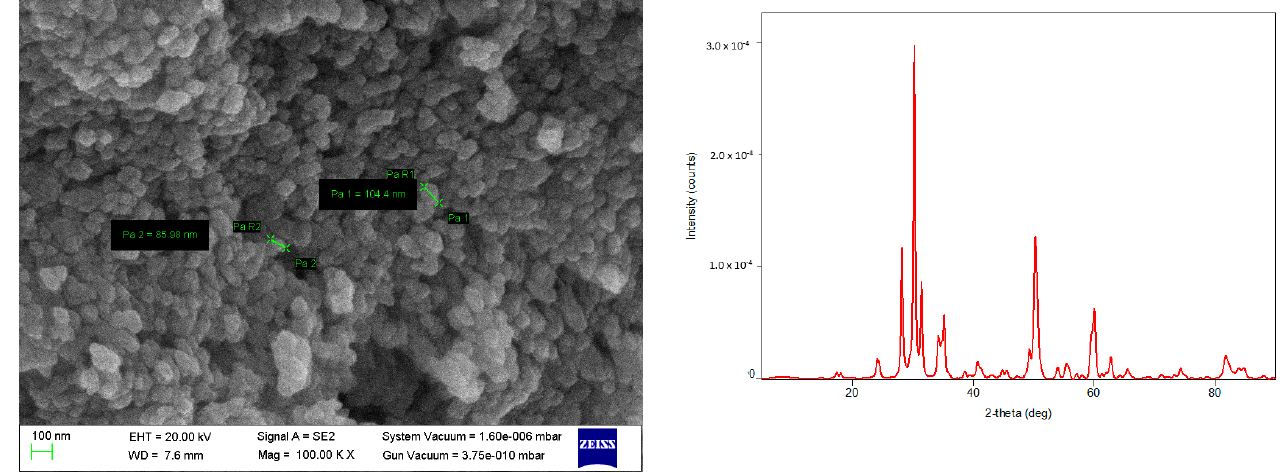
Figure 3. SEM and XRD of a CSZ powder sample with 15 mol% of CaO.